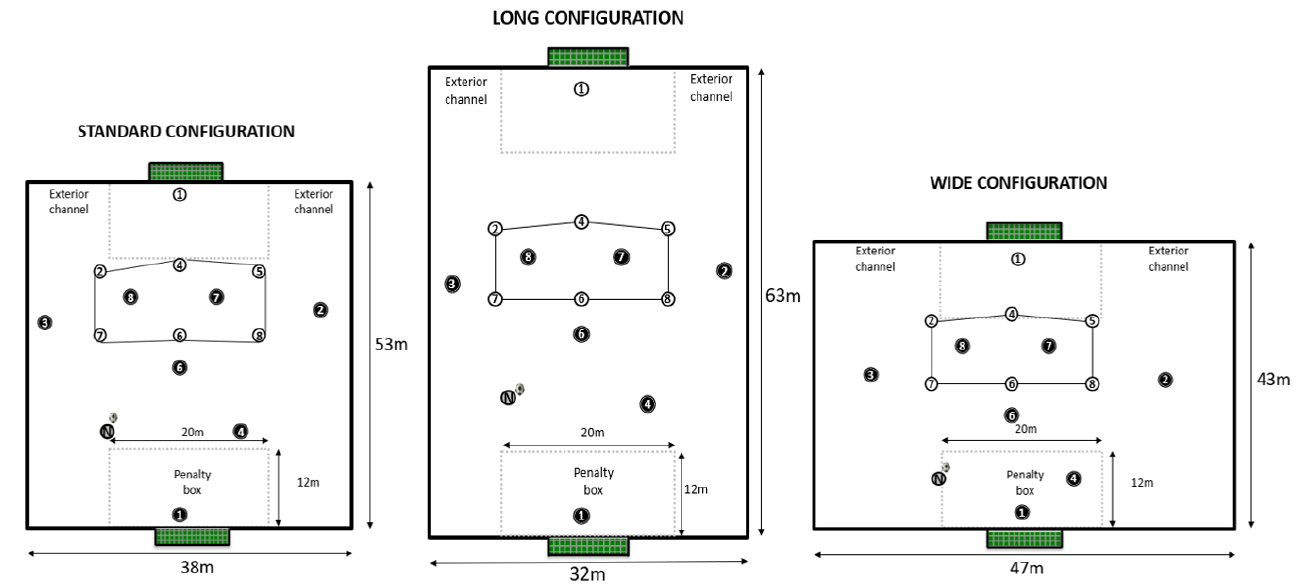
Figure 1. Different pitch configurations and field sizes of the small sided soccer